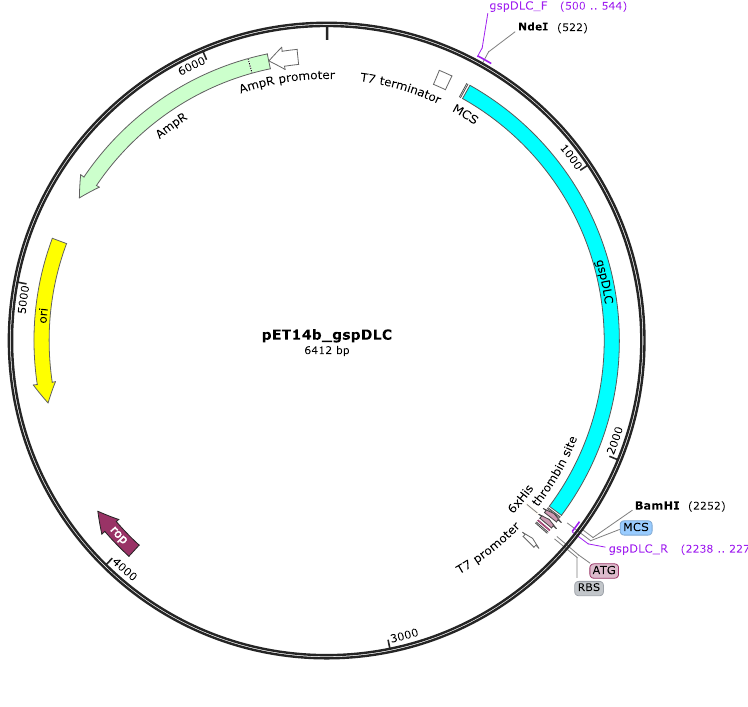
Figure 1. Map of the pET-14b_ gspDLC recombinant expression vector. The 1734 bp gspDLC cloned insert is shown in pale blue color. Nde I and Bam HI restriction digestion cloning sites are shown. The map was built with the SnapGene ™ 1.1.3 program. The fifteen first and last residues of the cloned peptide are shown, and numbers represent the actual numbered residue of GspD of Leptospira interrogans SV Canicola strain